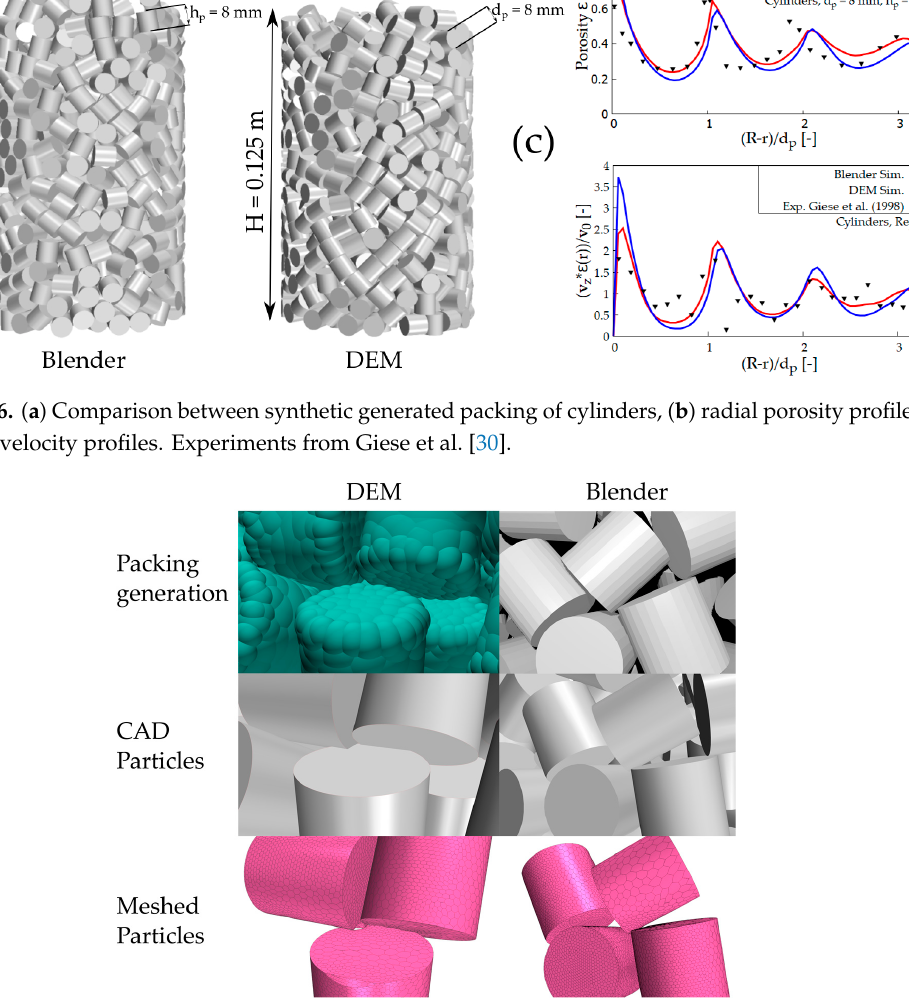
Figure 8. ( a ) Comparison between synthetic generated packing of cylinders, ( b ) radial density distribution, and ( c ) particle alignment. Experiments from Caulkin et al. [15]. The optical height of the generated beds in Figure 8a is not exactly similar, however, the near- wall particles show different orientations. In the Blender bed, the cylinders stack over each other,